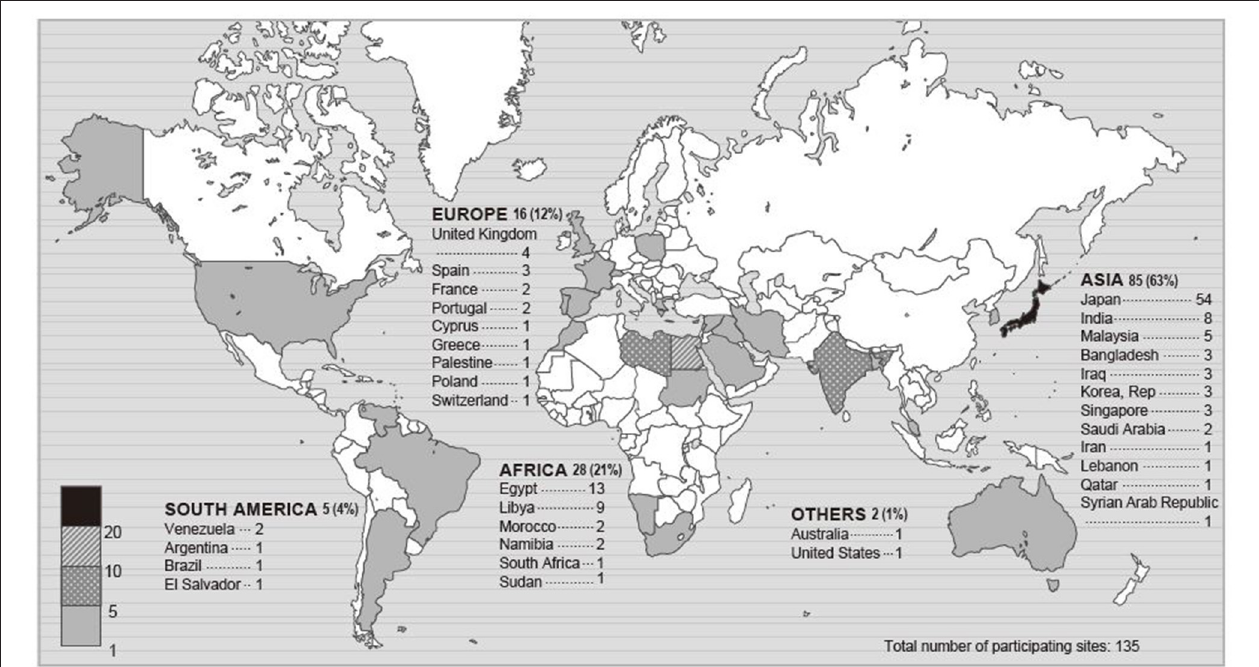
FIGURE 1 | Map of participating sites. The numbers in this figure indicate the number of participating ICUs in each country or a percentage. Percentage indicates the proportion of the total participating ICUs.